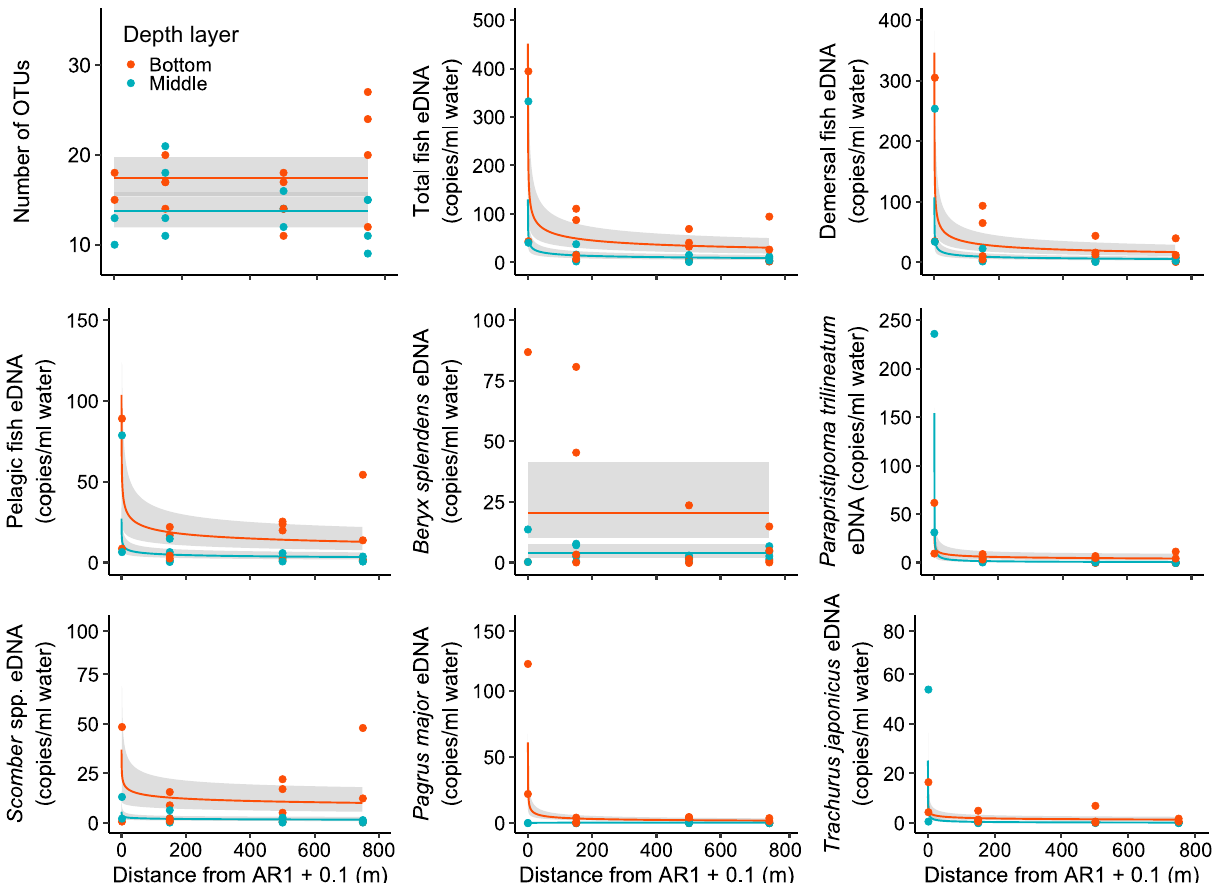
Figure 3. The relationships between distance from AR1 as well as number of OTUs and eDNA copies of total fish, demersal fish, pelagic fish, Beryx splendens , Parapristipoma trilineatum , Scomber spp., Pagrus major , and Trachurus japonicus . The red and turquoise blue lines indicate median values in the bottom and middle layers respectively, while each color circle indicates raw values in the respective layers. The gray shaded area represents a 95% confidence interval, as determined from the generalized linear